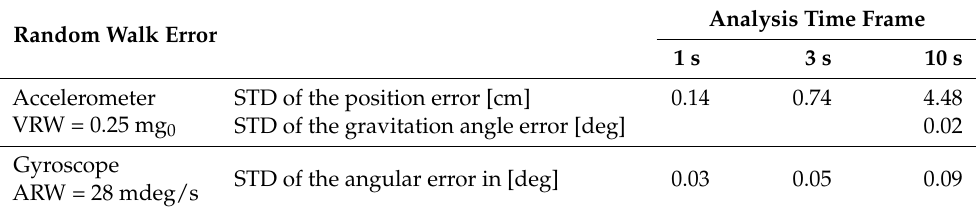
Table 3. Predicted random walk errors induced by accelerometer and gyroscope white noise. Values in the table represent standard